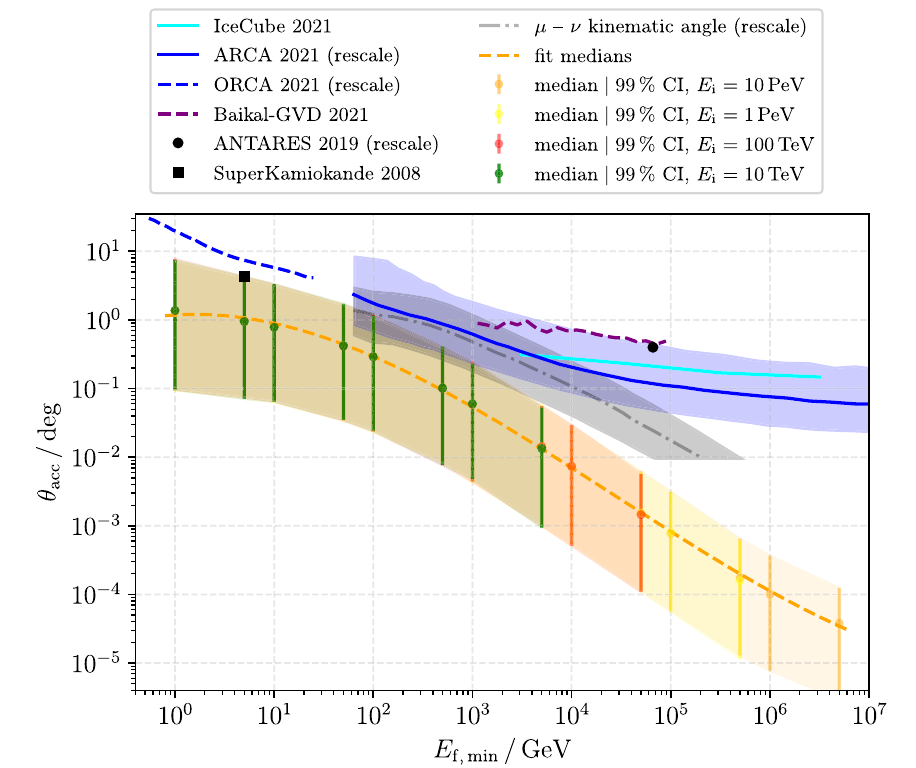
Fig. 5 The median of the accumulated deflection θ acc in degree with a 99% central interval is shown for four different initial energies E i . Each data set includes more than 50000 events with the requirement that the true final muon energy E f is at most 10% below the set final energy E f , min , E f > E f , min · 0 . 9. The energy cuts are e cut = 500 MeV and v cut = 0 . 05, and Molière scattering is chosen. Simulations are performed in ice, the deviations of the medians in a water-based simu- lationaresmallerthan1%.Sincethemediansoverlapfordifferentinitial energies, there is no strong impact of the initial energy on the median deflection. These medians can be fit by a third degree polynomial in the log-space as shown in Eq. (2). The kinematic angle between the muon